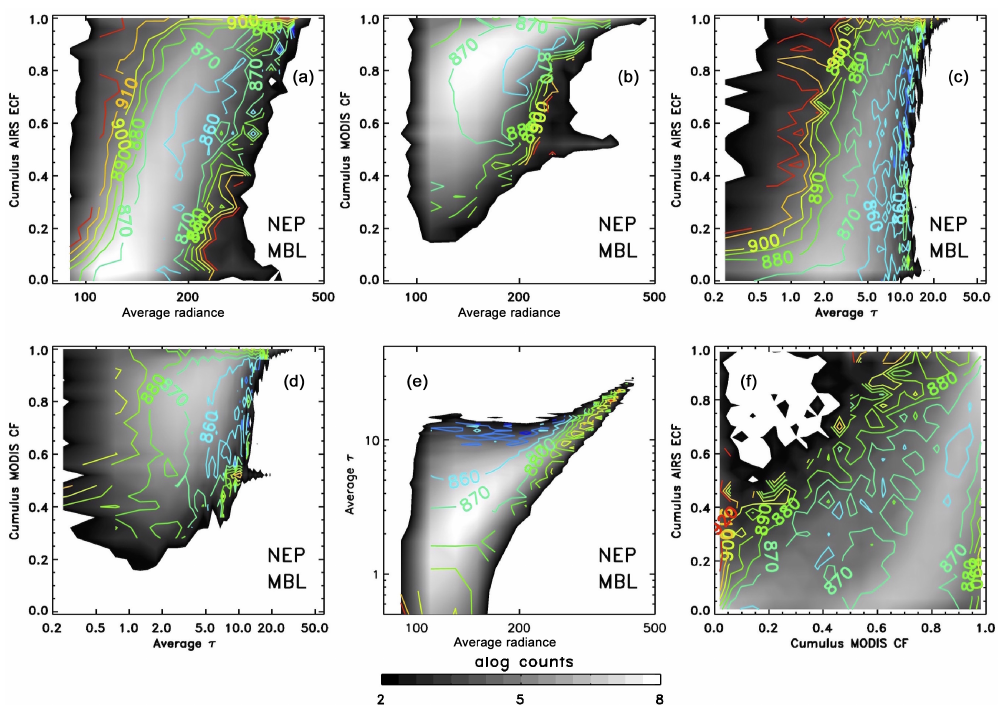
Figure 7. Shown are joint PDFs for six different combinations of variables that are described in Sect. 4.2: (a) radiance versus AIRS ECF, (b) radiance versus MODIS CF, (c) MODIS τ versus AIRS ECF, (d) MODIS τ versus MODIS CF, (e) radiance versus MODIS τ , and (f) MODIS CF versus AIRS ECF. The gray scale is the natural log of total counts per bin. All values in the PDFs shown are for the cumulus regime. The color contours depict the MBL depth